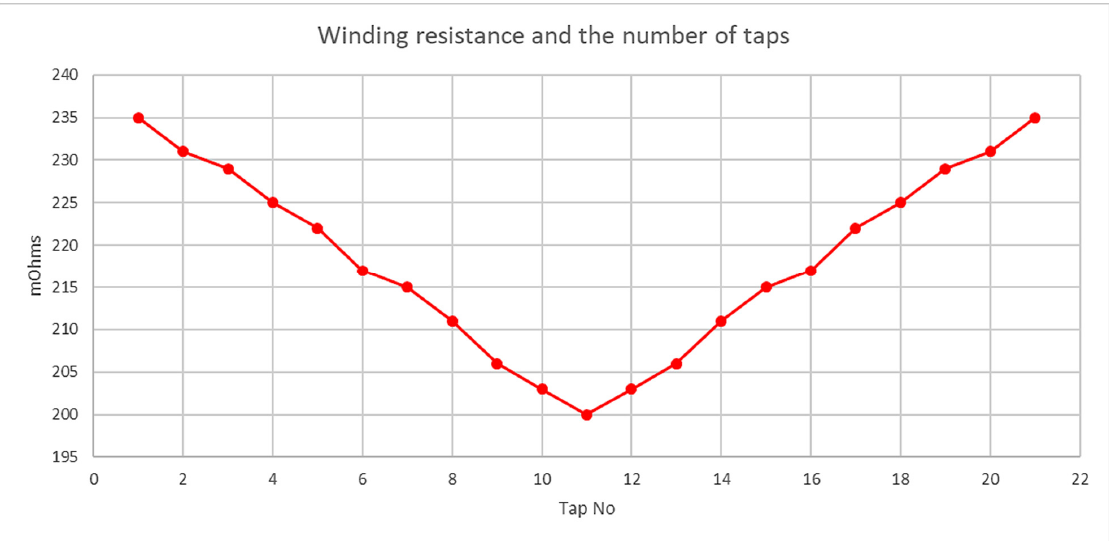
Figure 12. A typical graph of a 21 ‐ tap OLTC with a reversing switch and selector switch winding resistance against the tap number result [47].